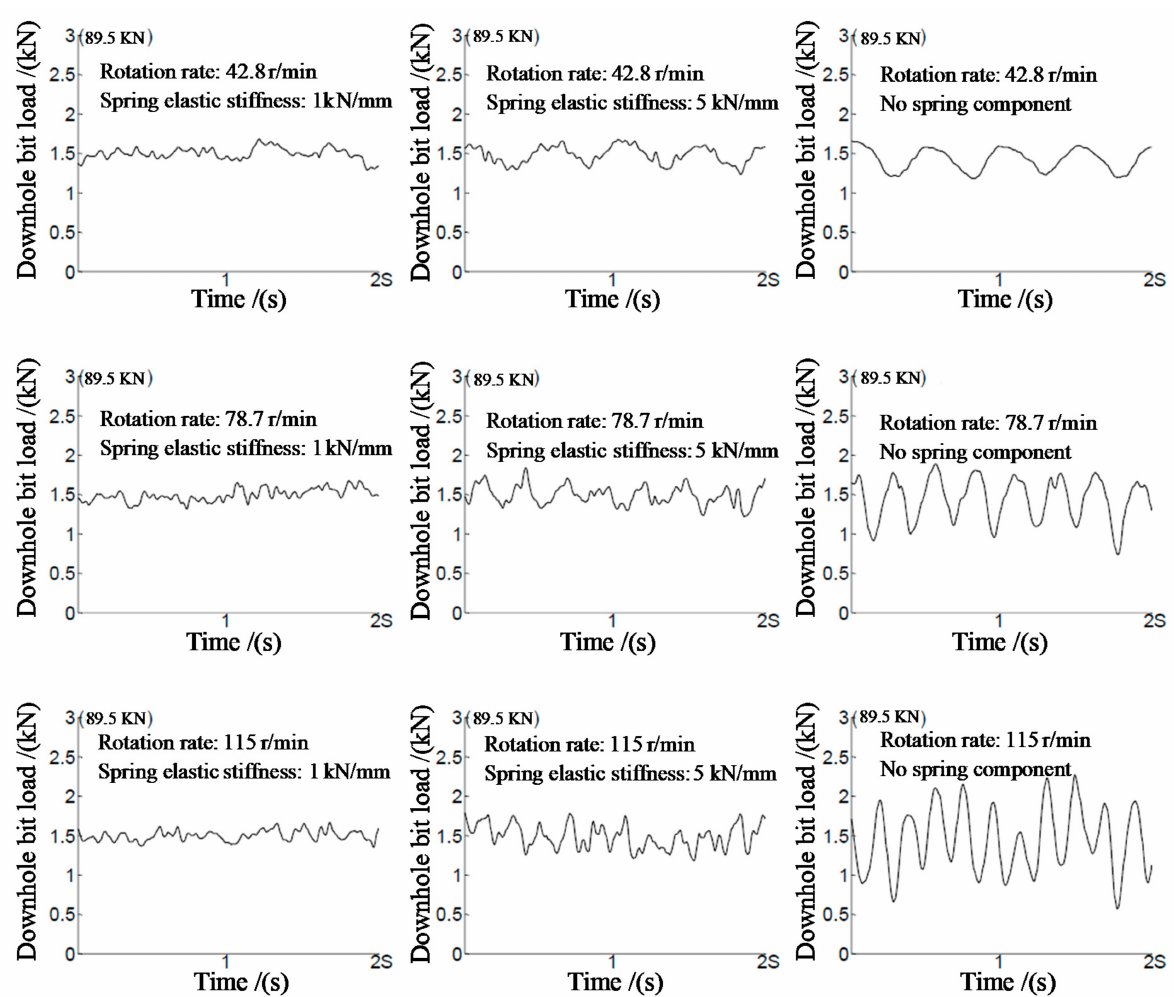
Figure 6. The variation of the downhole bit load under different